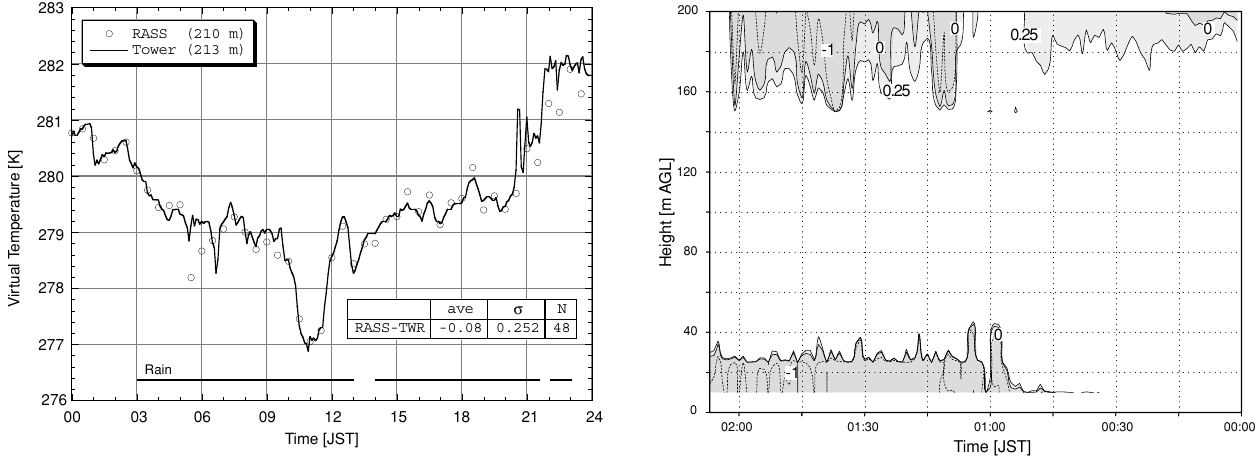
Fig. 10. Time-height cross section of gradient Richardson number ( Ri ) derived from the tower measurements at 00:00 to 02:05 JST on 30 December 1997. Time runs right to left, and contours with shaded areas represent Ri <